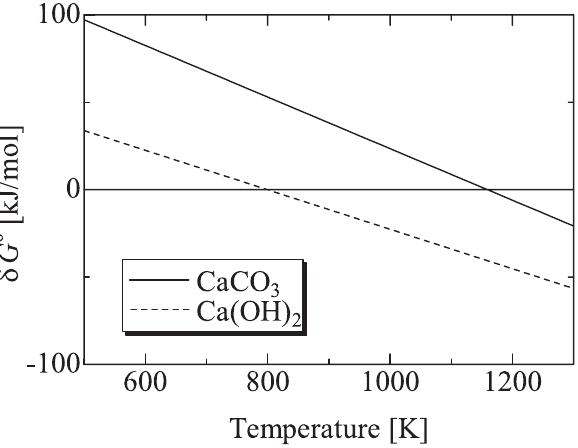
Fig. 21: Gibbs free energy of formation as a function of